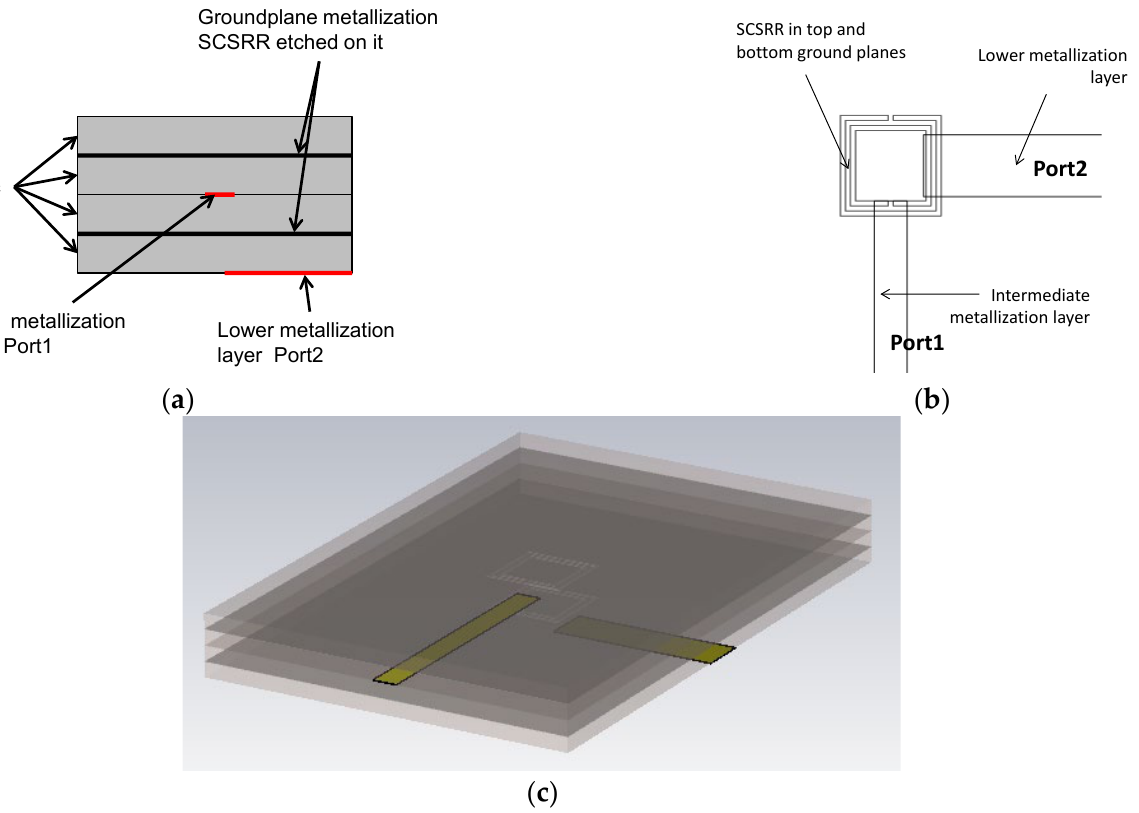
Figure 11. ( a ) Front view. Stacked layer distribution: ( b ) top view of the SCSRR power divider; ( c ) perspective view of the stacked layers.